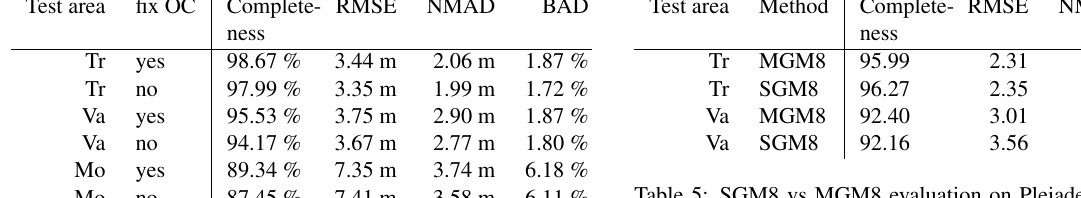
Table 5: SGM8 vs MGM8 evaluation on Pleiades Triplet. The BAD column gives the percentage of pixels with errors > 5 m.